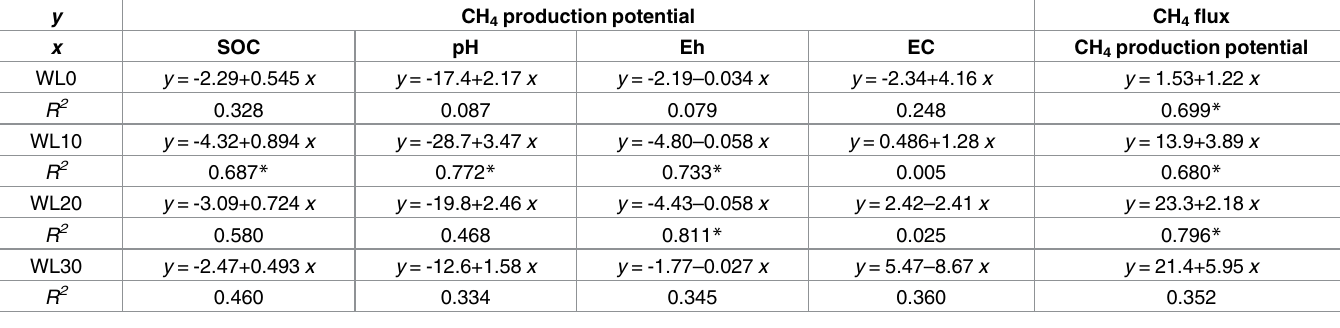
Table 3. Correlation between soil CH 4 production potential and soil physical and chemical